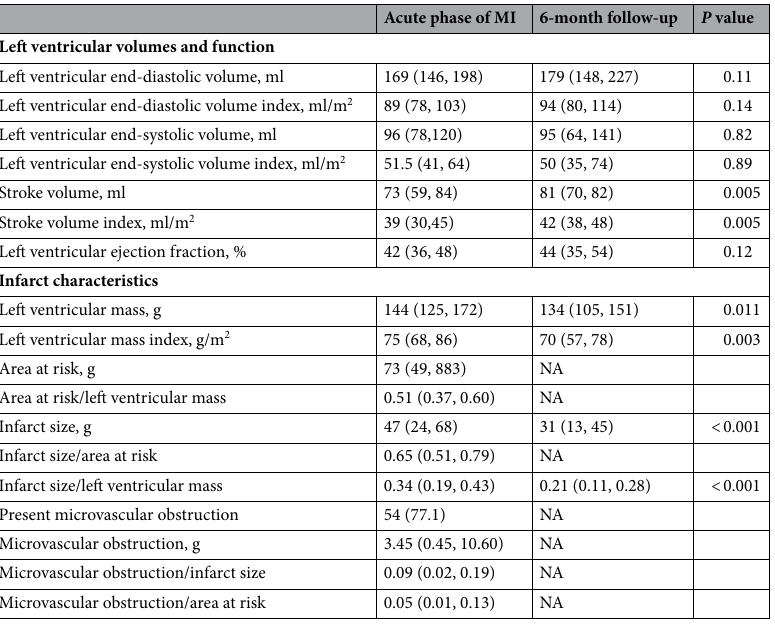
Table 2. Left ventricular volumes, function and infarct characteristics. Data are shown as median (interquartile range). MI myocardial infarction, NA not